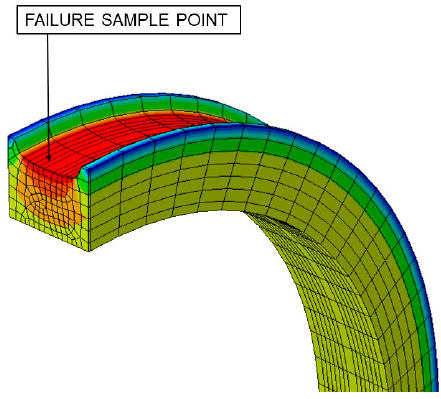
Figure 4. FEM simulation for test A1.